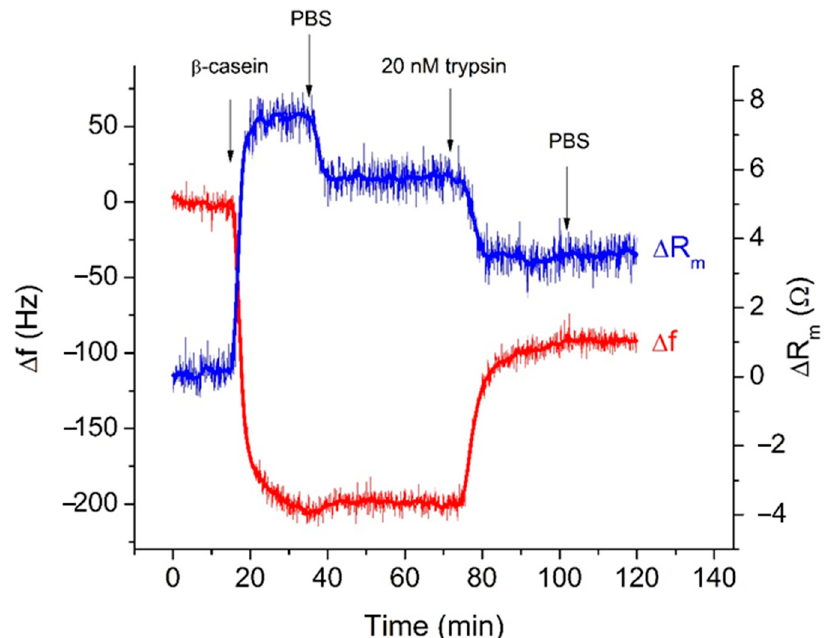
Figure 3. Typical kinetics of the changes of resonant frequency, ∆ f, and motional resistance, ∆ R m , of the thickness-shear mode (TSM) transducer for various modifications. The additions of β -casein, trypsin, and washing of the surface by phosphate - buffered saline (PBS) are shown by arrows.